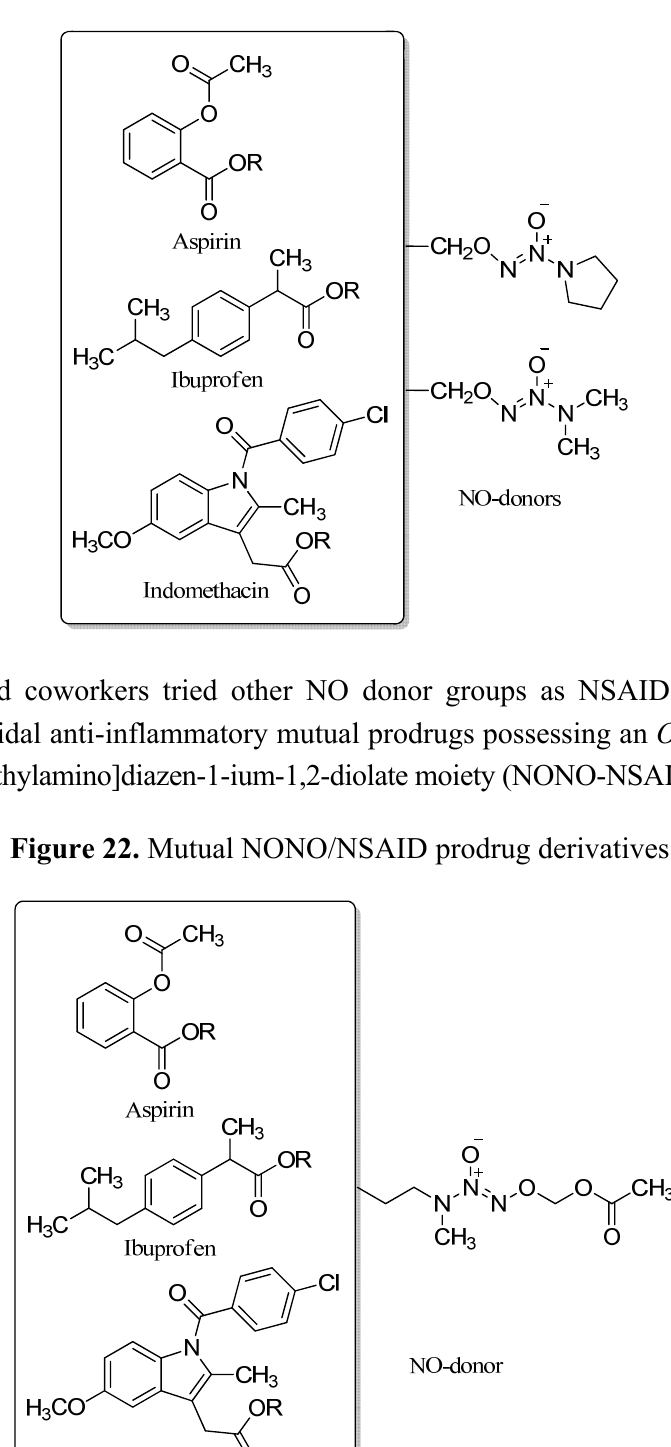
Figure 21. Hybrid of a classical NSAID and NO donor.